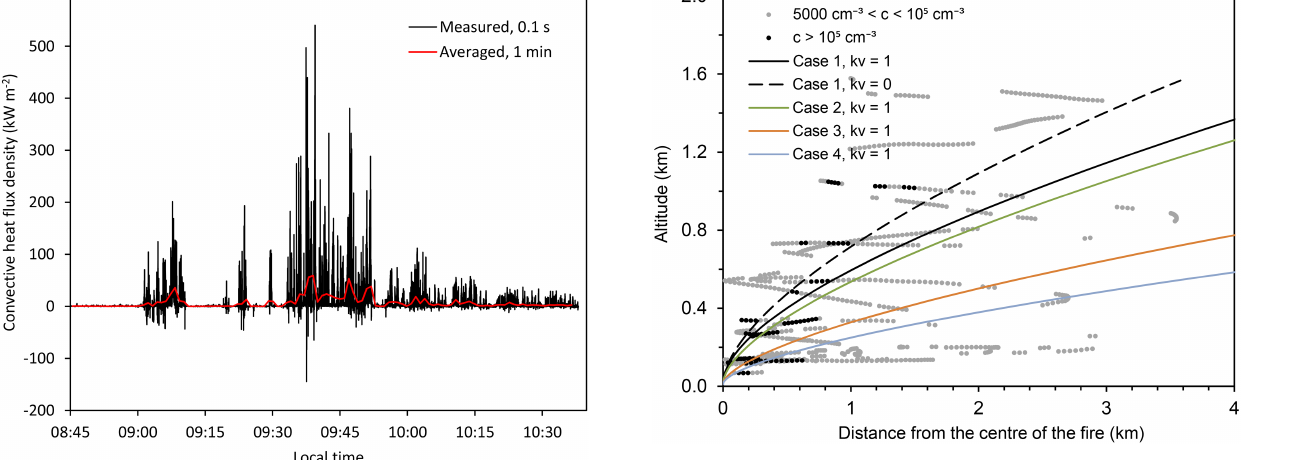
Figure 5. Computed convective heat flux density, determined from measurements during most of the flaming phase (black line). The measuring frequency was 10Hz. The 1min average value of the convective heat flux density is also presented (red line).